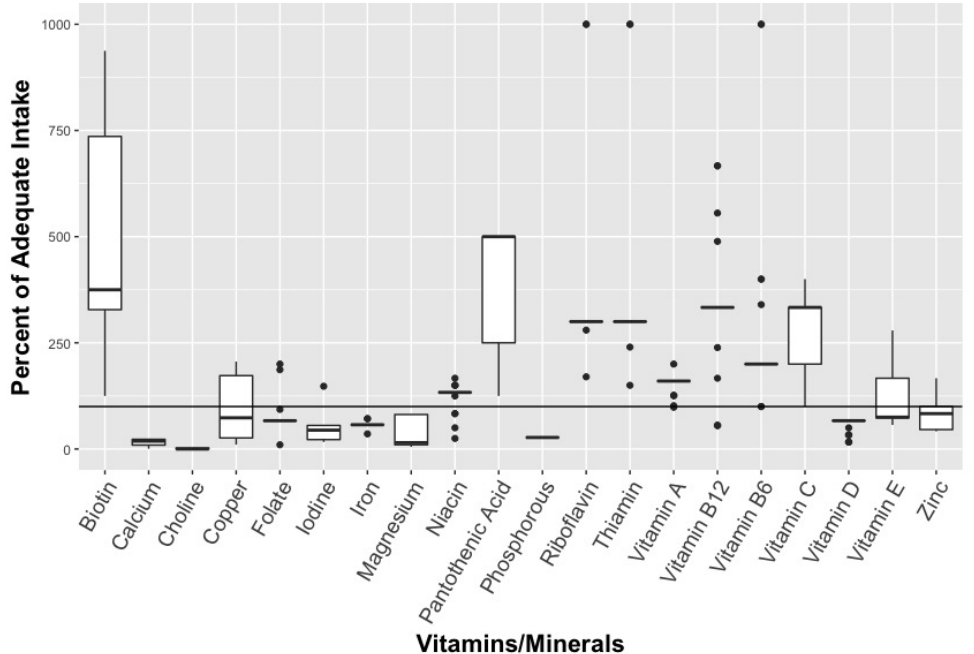
Figure 1. Percent of recommended vitamins/minerals for 2–3 year old in multivitamin supplements (n = 32). * Solid line represents median estimate, with top and bottom of box representing quartiles (if sufficient data). Y—axis was truncated at 1000% to allow appropriate visualization of the estimates.